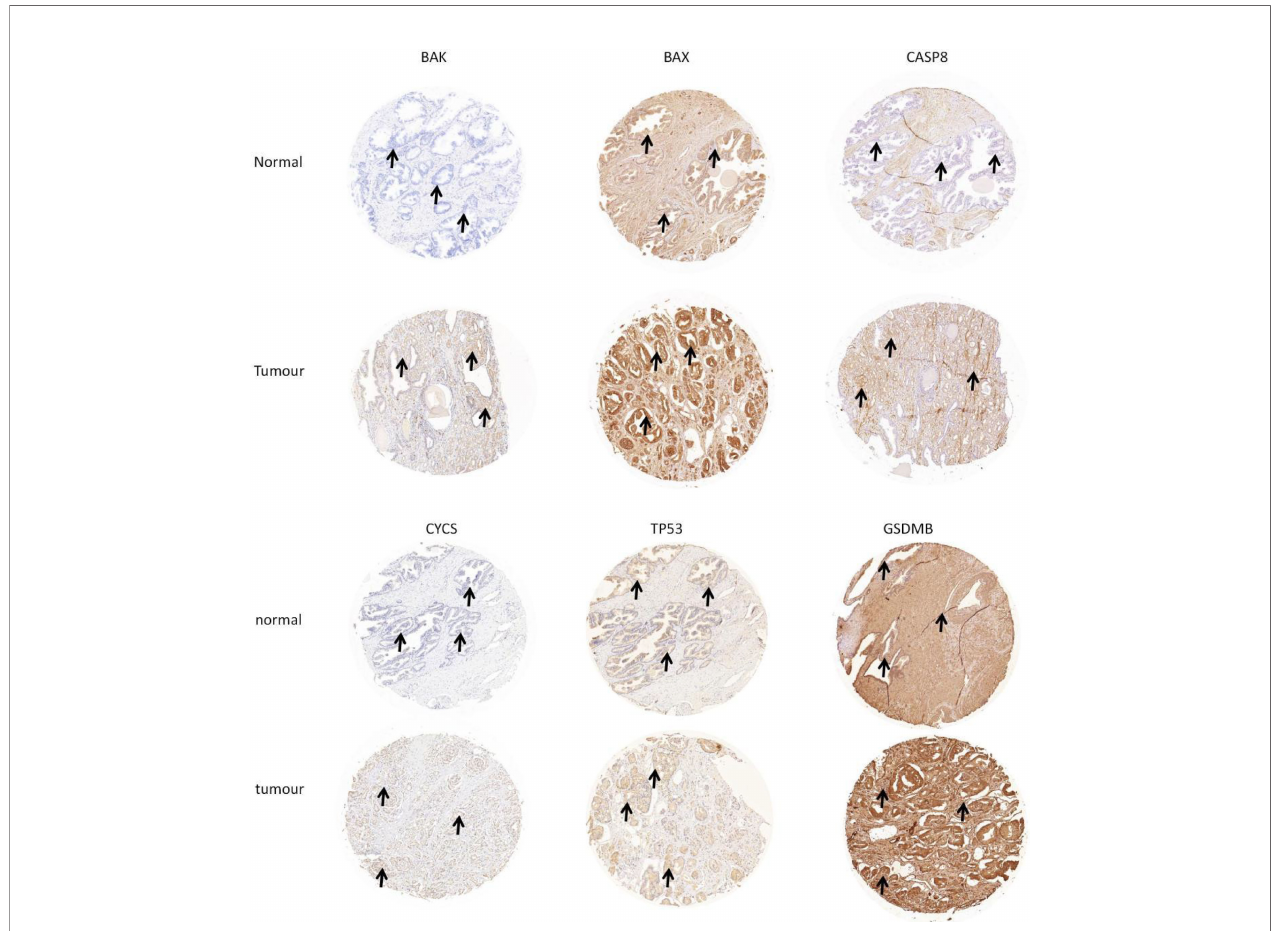
FIGURE 4 | Veri fi cation of hub DE-PROs expressions in normal and tumour tissue with lmmunohistochemistry (lHC), the expression of glandular epithelium (cytoplasm, cell membrane) in tumour group was signi fi cantly higher than that in normal group (obviously deepened in yellowish brown compared to normal groups. “ ! ”